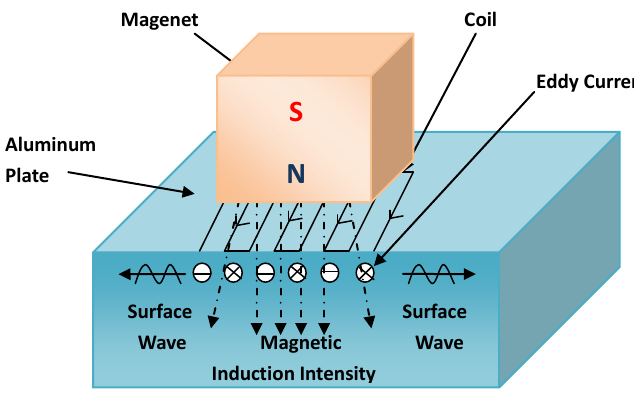
Figure 10. Schematic diagram of an electromagnetic acoustic transducer (EMATS).